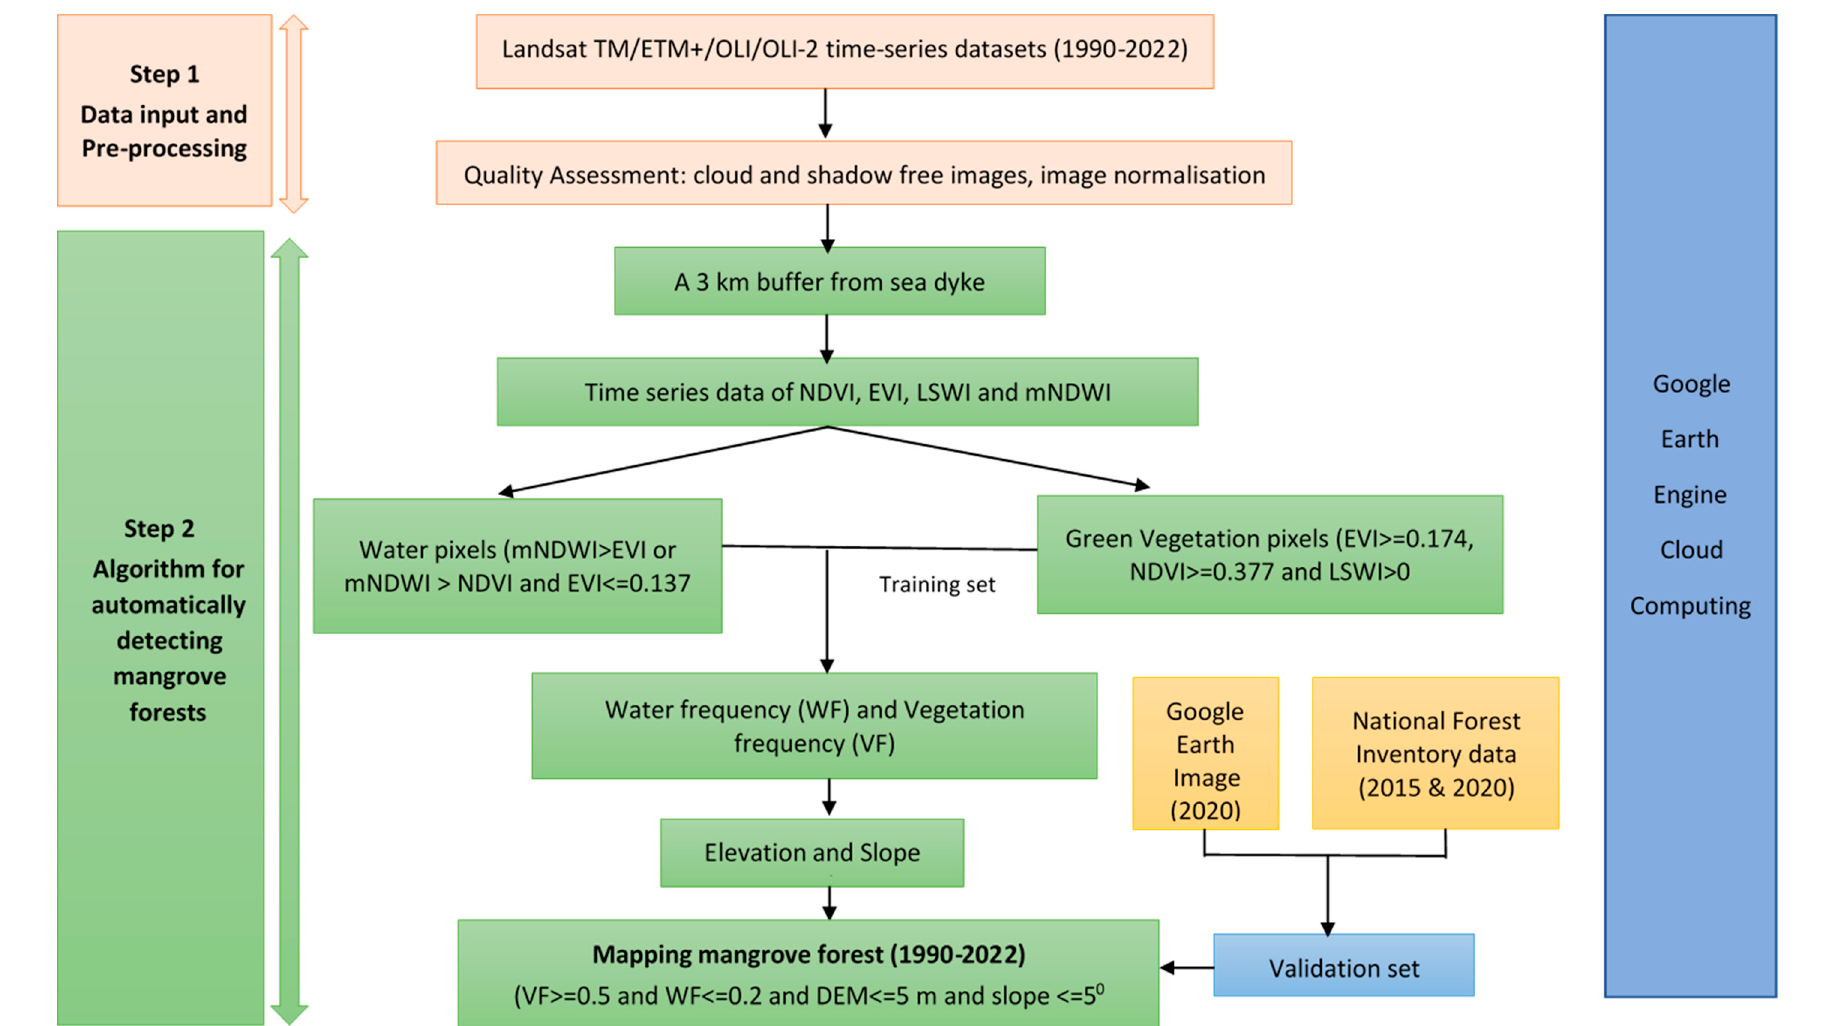
Figure 3. A framework developed in this study for mangrove mapping and change detection using a pixel-based algorithm.